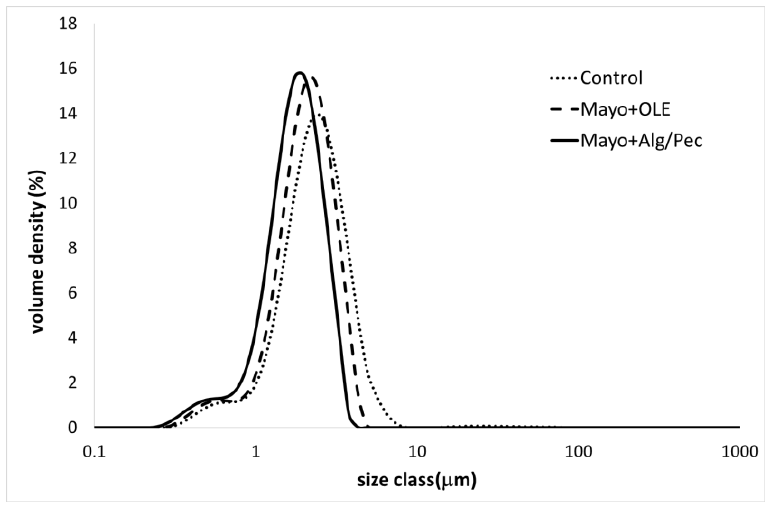
Figure 1. Particle size distribution curves of the differently enriched mayonnaise samples after